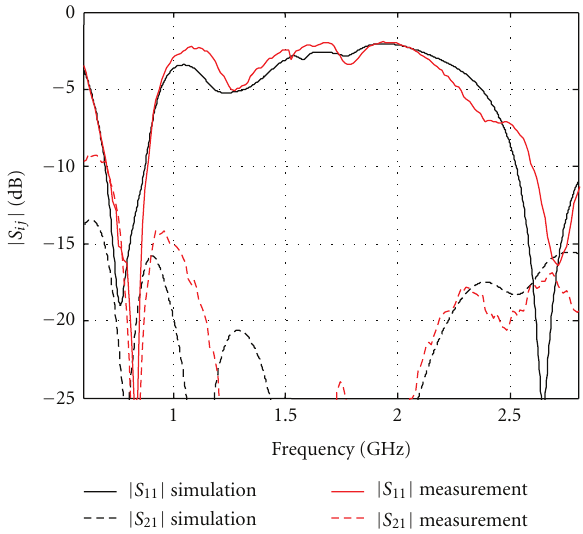
Figure 7: Simulated total e ffi ciency in the lower band for the optimized three bend endings antennas with added ground plane and